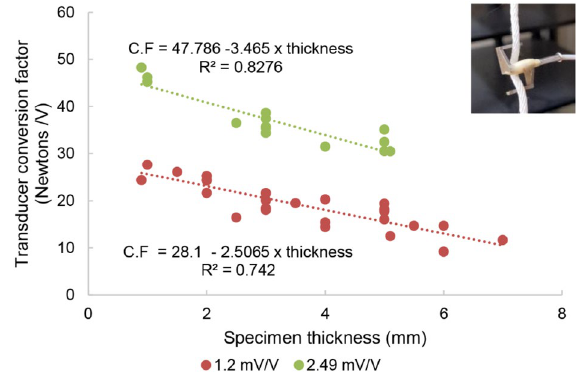
Figure 3. Conversion factor (C.F) for the BFT as a function of specimen thickness. Data is shown for two gain settings (1.2 mV/V and 2.49 mV/V). Inset image shows an example of material used to calibrate the force transducer in the